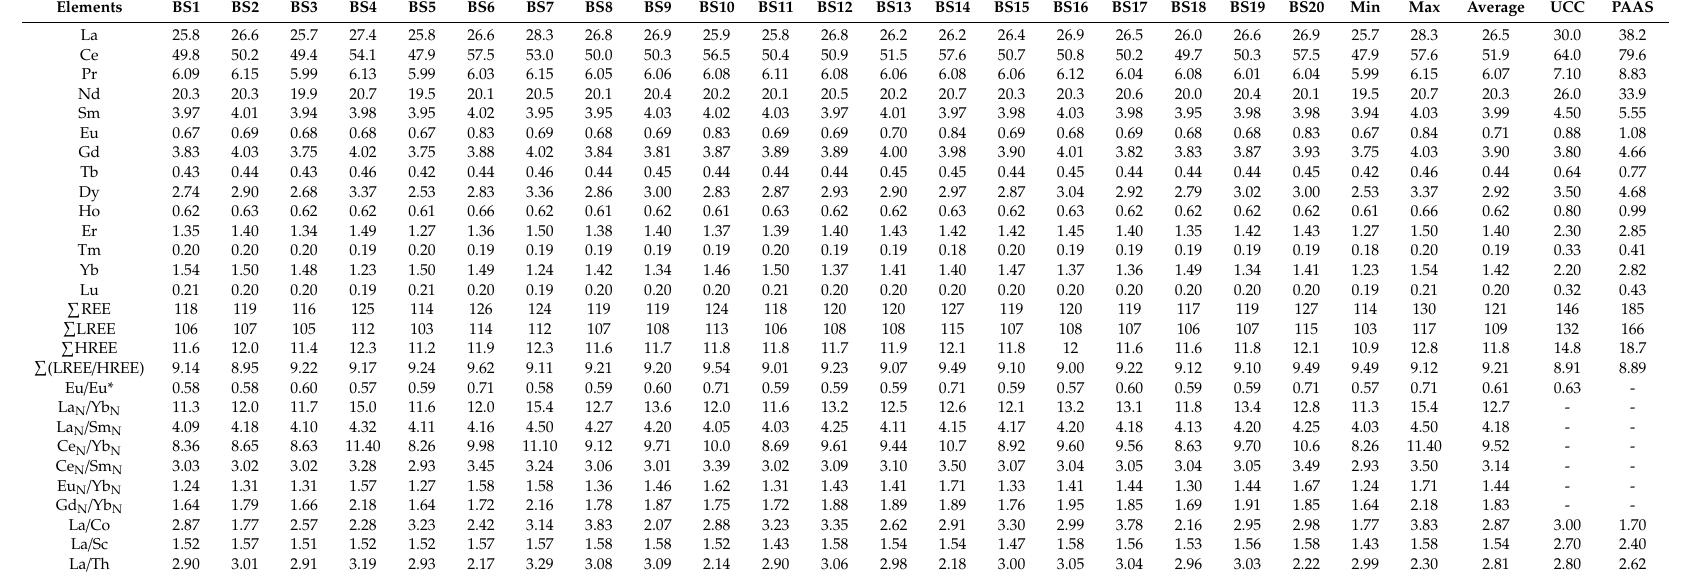
Table 3. Rare earth element compositions (ppm) and elemental ratios of the Brahmaputra River